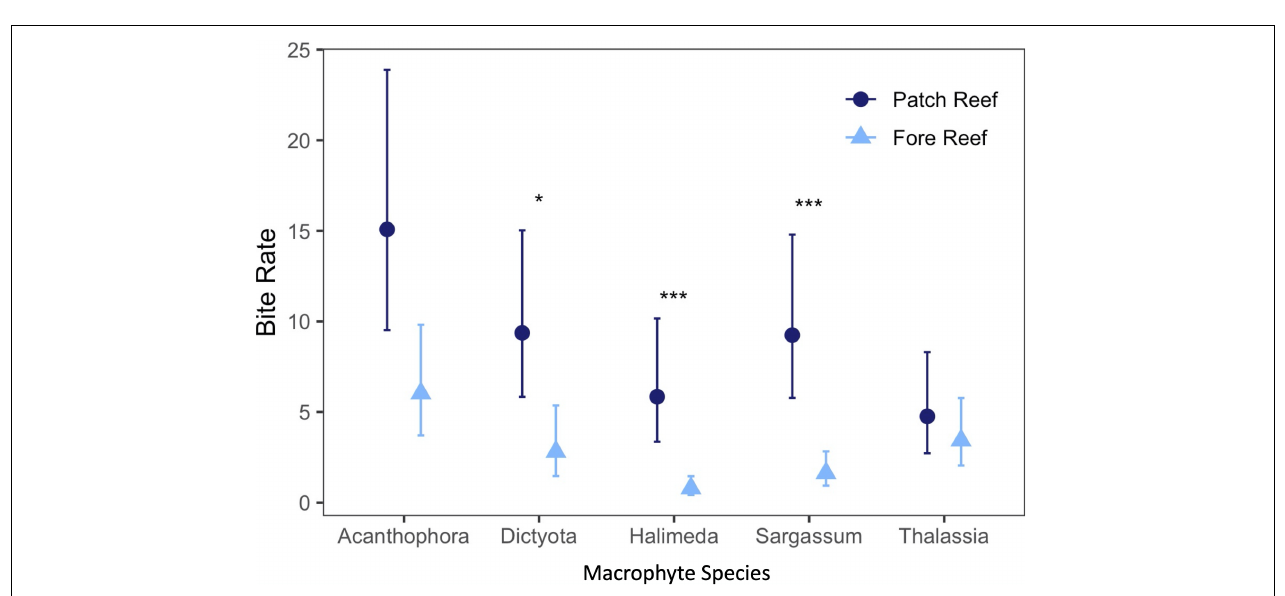
FIGURE 5 | Differences in bites per hour by location during a 1-h video survey in 2017 on patch and fore reef sites. Asterisks denote significance in pairwise contrasts conducted post hoc (* = < 0.05, *** = < 0.001).